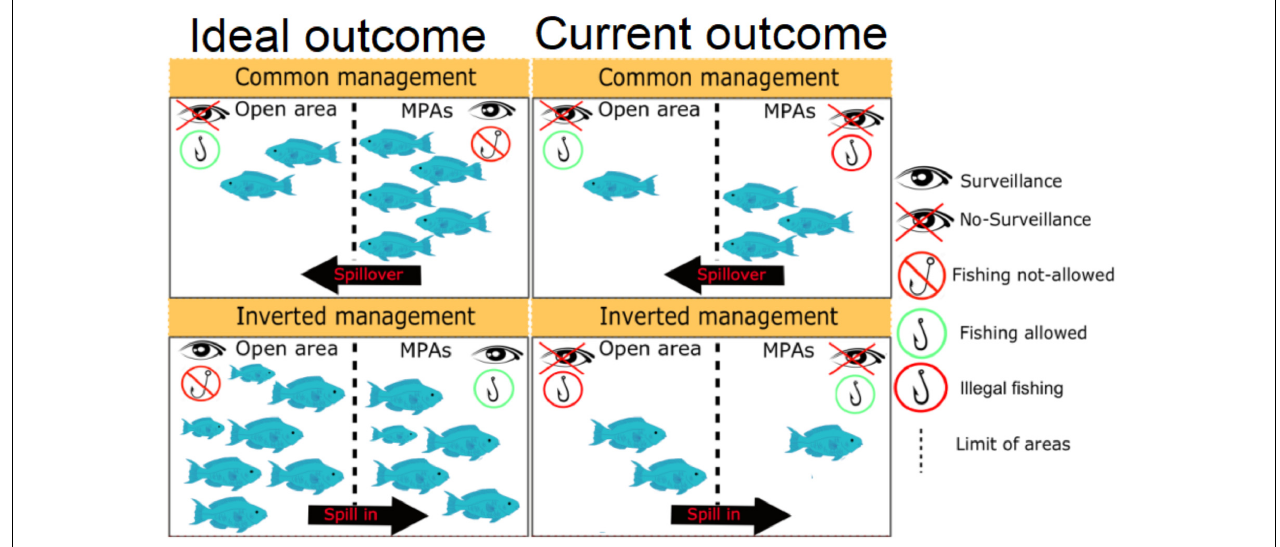
FIGURE 3 | Scheme contrasting management strategies and showing the ideal outcomes versus the current outcomes of low- and lower-middle income countries marine protected areas.